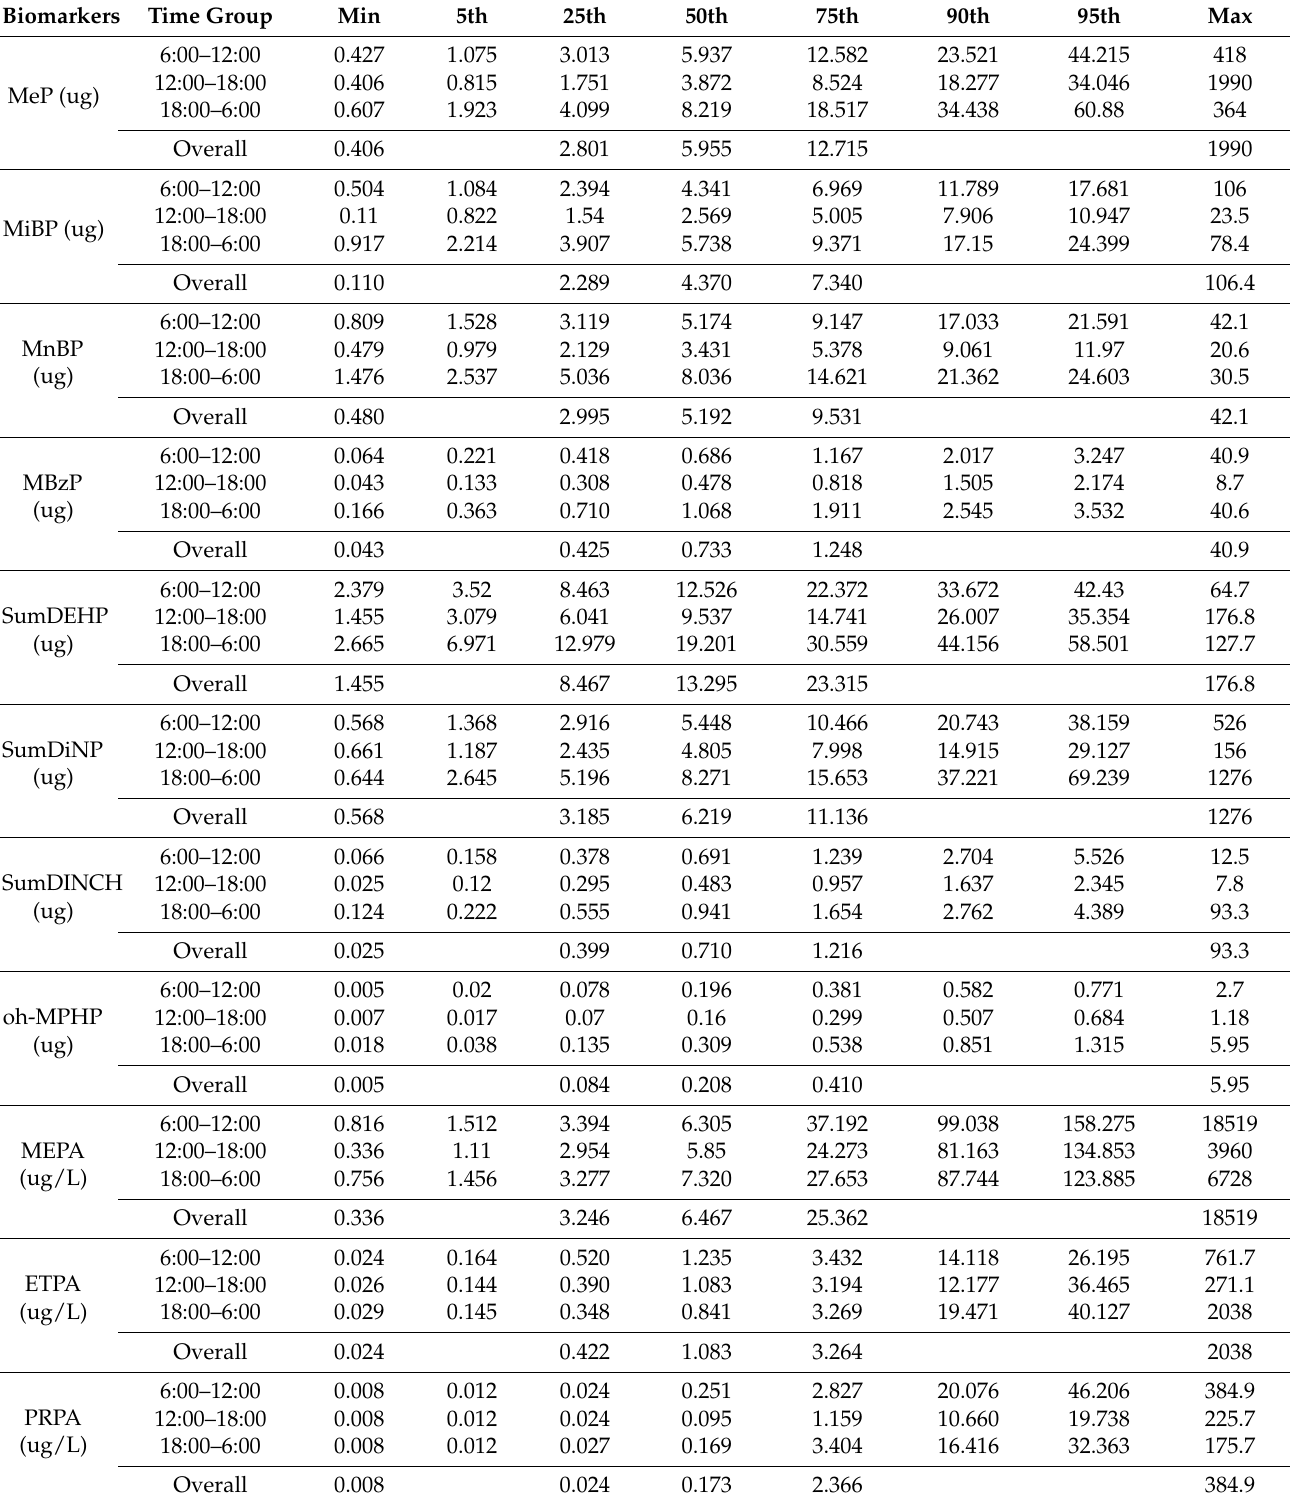
Table 2. Percentiles of the specific gravity-adjusted biomarkers of exposure to EDCs and